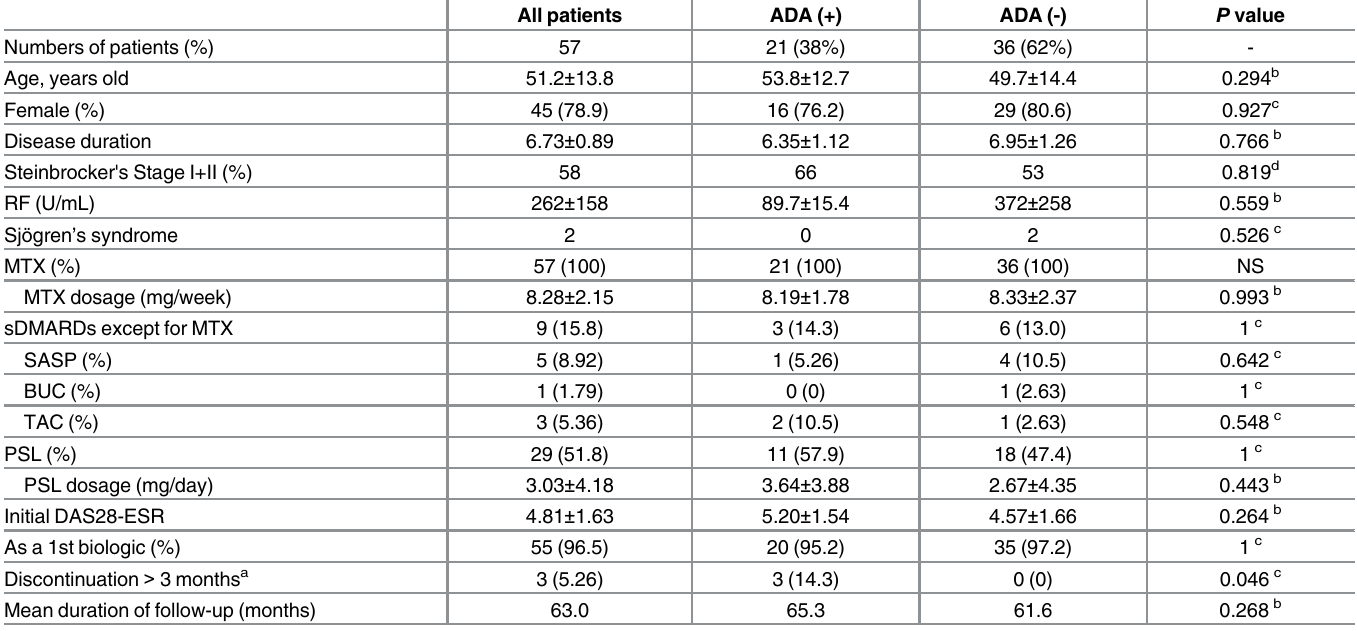
Table 1. Clinical features of the patients enrolled in this